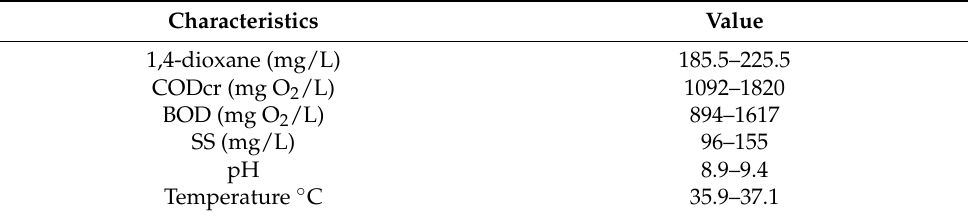
Table 1. Characteristics of industrial